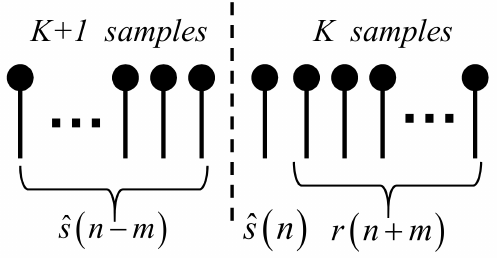
Figure 12. The data samples used in the computation of the sequential cubic phase function